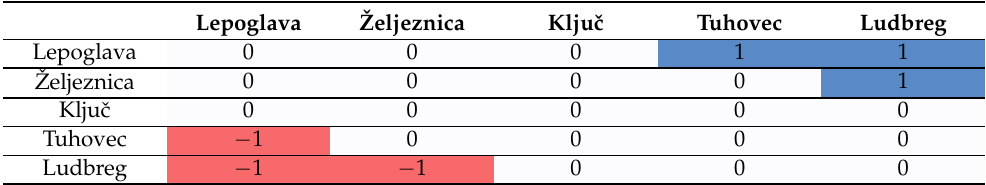
Table 5. Cross-correlation lag times matrix for the measurement stations. The red to blue color bar indicates values between − 1 and